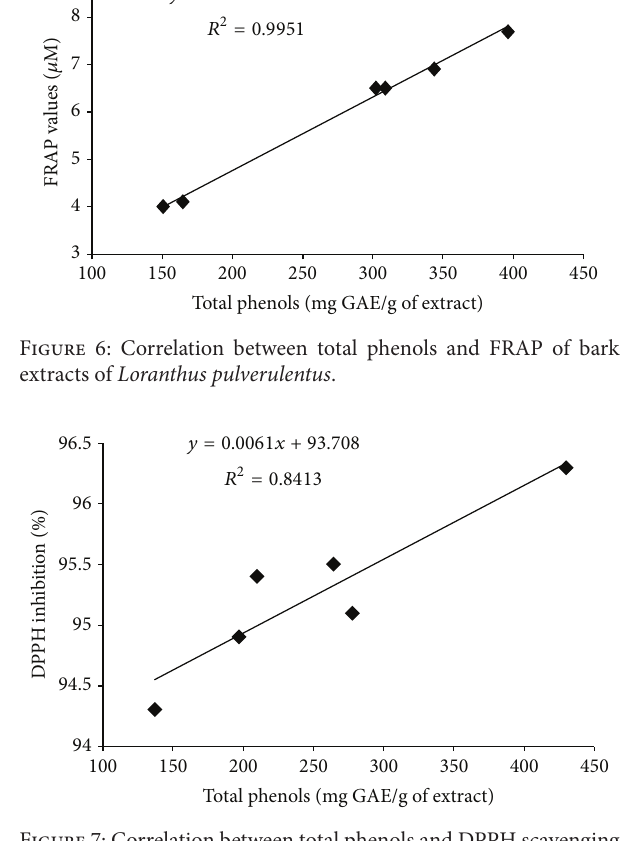
Figure 7: Correlation between total phenols and DPPH scavenging activity of leave extracts of Loranthus pulverulentus .